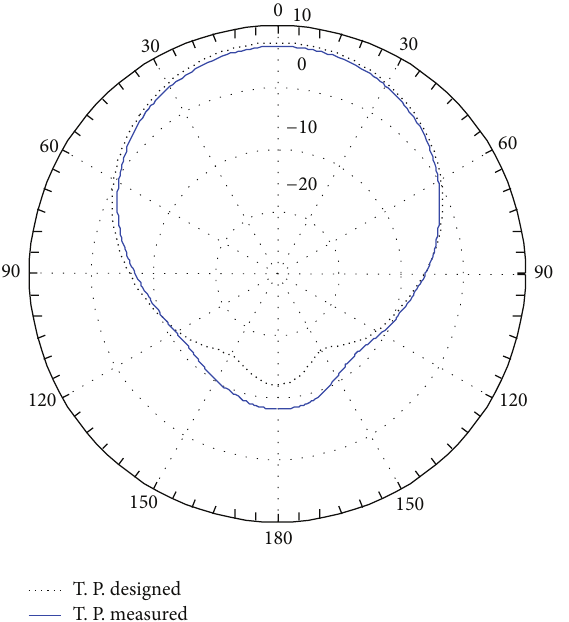
Figure 8: Simulation and measurement results for 𝐸 -plane gain of miniaturized patch with longer feed line (frequency: 5.51GHz).